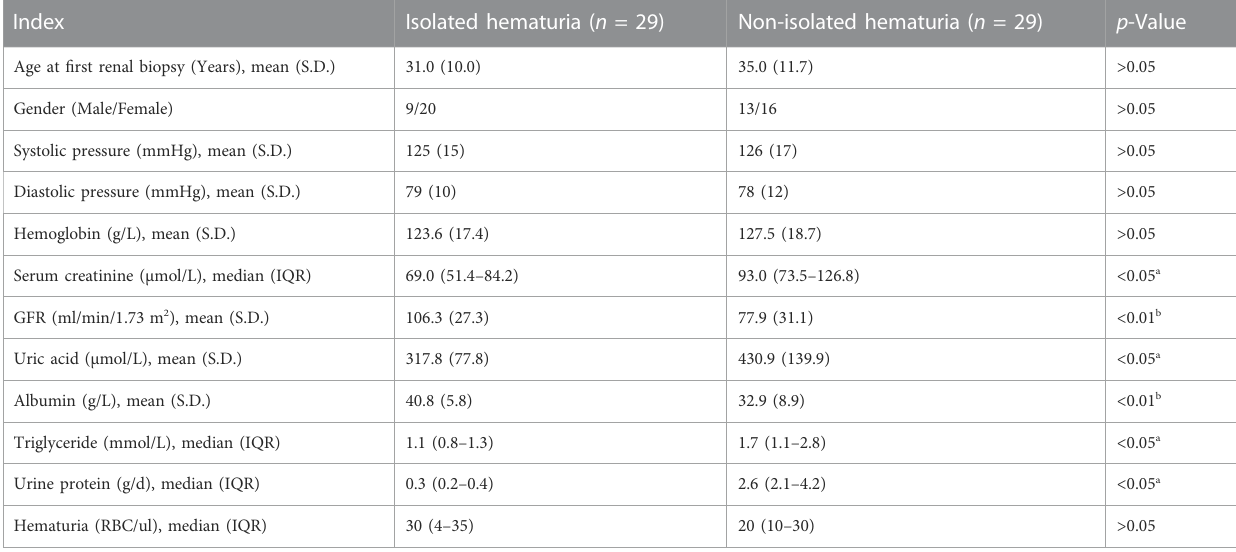
TABLE 1 Comparison of baseline data of patients with isolated hematuria and non-isolated hematuria. Index Isolated hematuria ( n = 29) Non-isolated hematuria ( n = 29) p -Value Age at fi rst renal biopsy (Years), mean (S.D.)